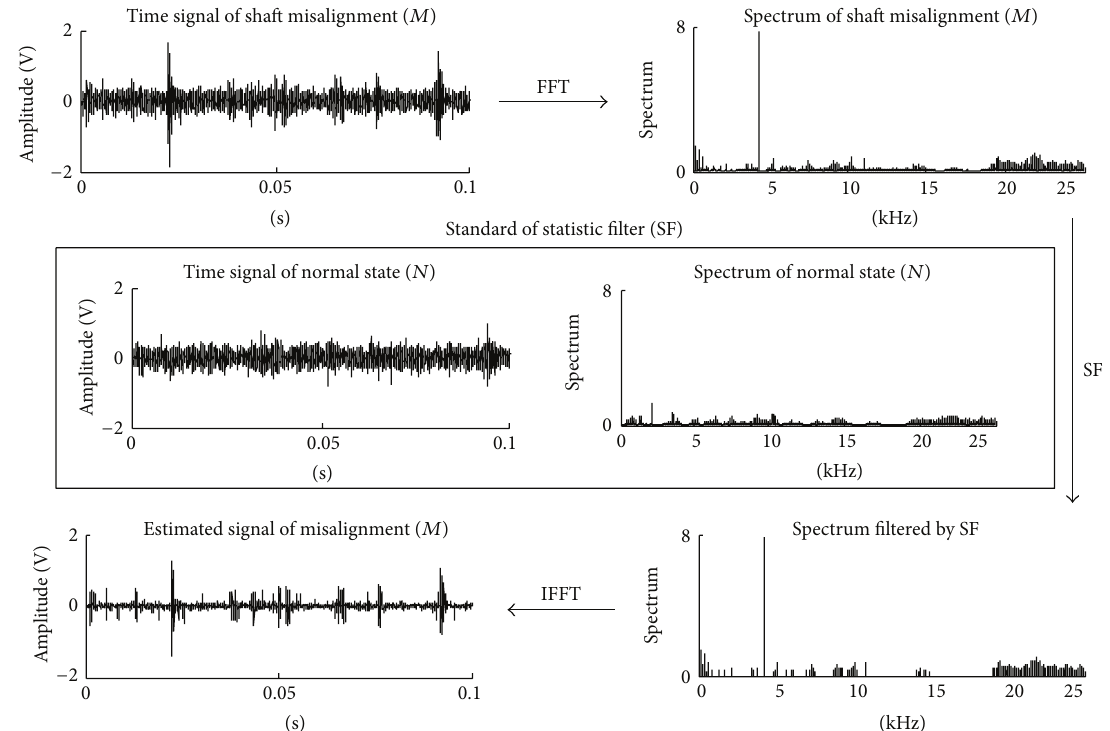
Figure 7: Estimated signal of shaft misalignment in sever step using statistic filter based on distinction index of spectrum.